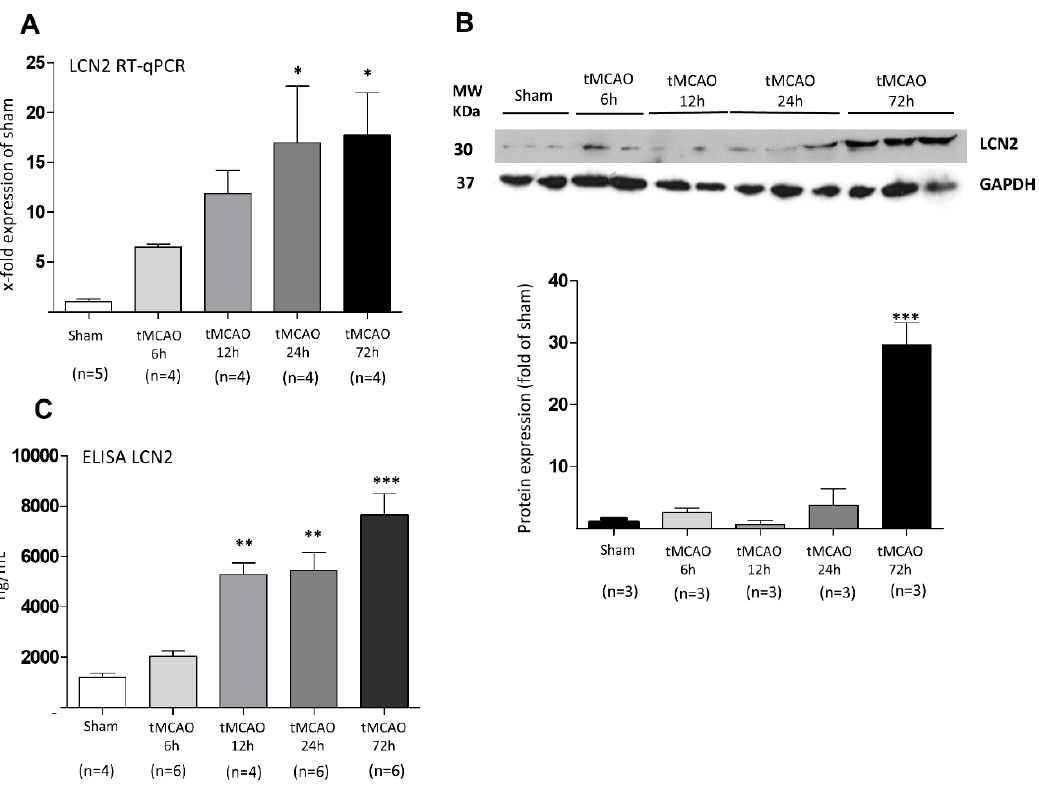
Figure 1. Regulation of LCN2 at ( A ) mRNA and ( B ) protein levels at various time points after tMCAO in the peri-infarct zone of the rat brain. ( A ) mRNA levels increased stepwise and changes became first significant after 24 h. ( B ) LCN2 protein amounts increased in a temporally delayed way as shown in representative WB samples and by densitometric evaluation of immune-labeled bands. ( C ) LCN2 ELISA determinations in the blood serum of rats show a significant increase of LCN2 coinciding well with the above described expression levels in the damaged cortical brain area. * p ≤ 0.05, ** p ≤ 0.01, and *** p ≤ 0.001.